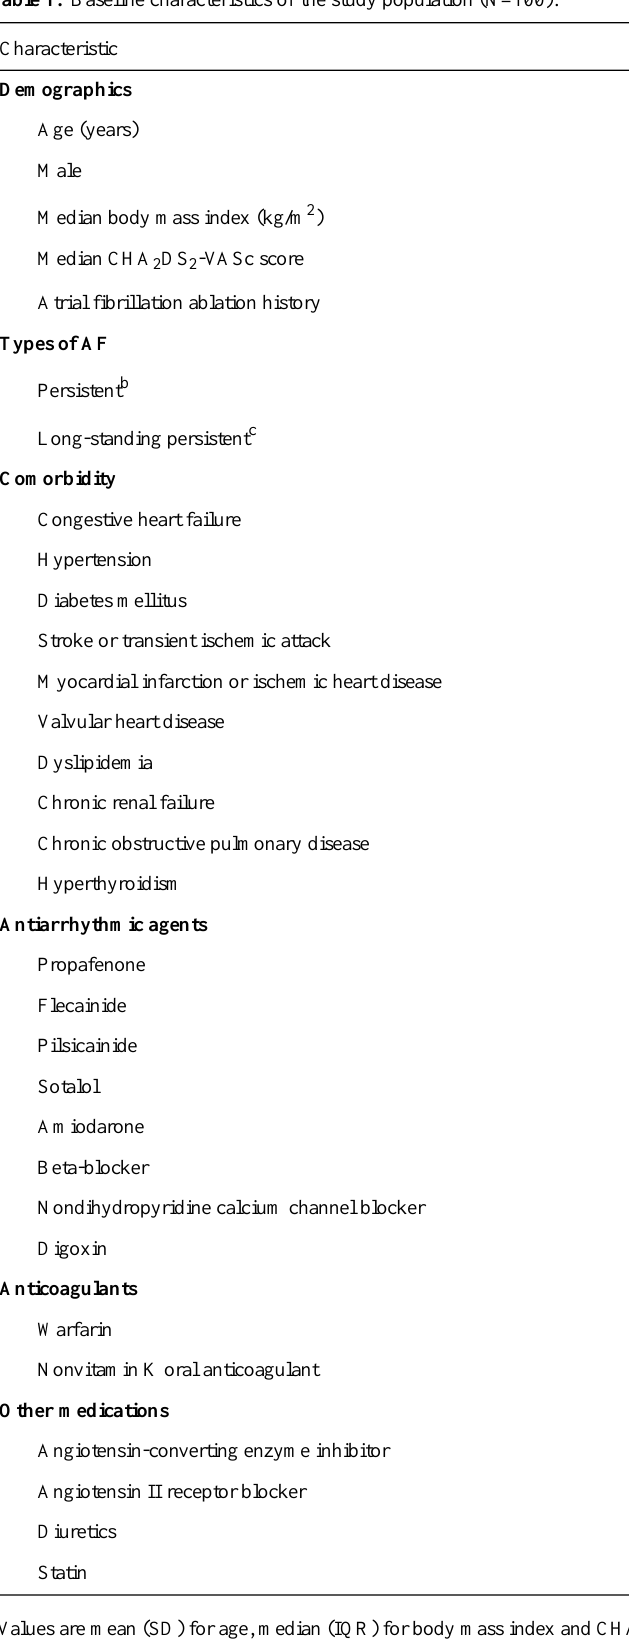
Table 1. Baseline characteristics of the study population